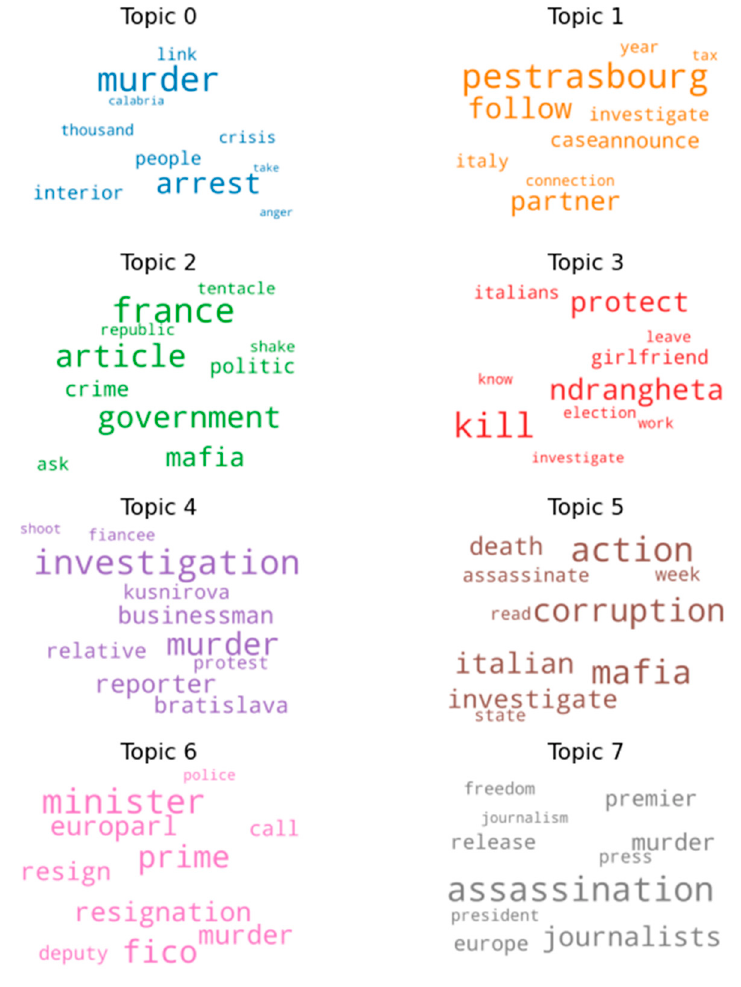
Figure 9. Topic modeling results for tweets in Cluster 1 (RQ2b and RQ3b). Table 2. Topic modeling results of Cluster 1 with representative text for each topic (The text is already pre-processed so it might not always make sense grammatically)—RQ2b and RQ3b. Representative